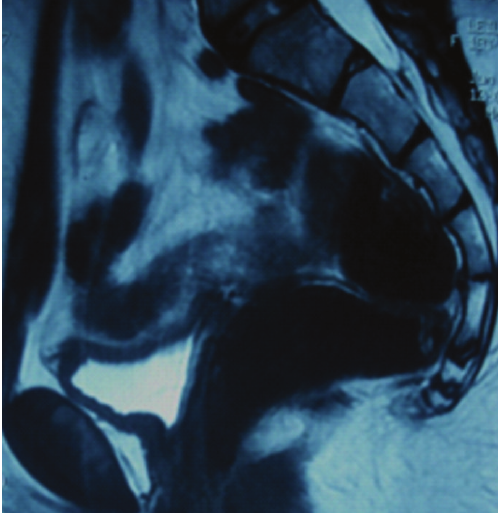
Figure 4: MRI examination sagittal plane cut: absence of uterus and